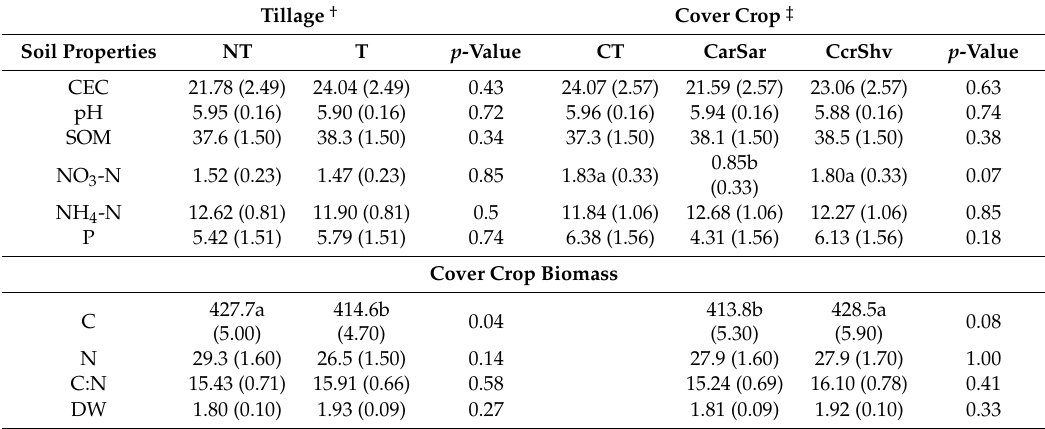
Table 1. Treatment mean values and standard errors of the mean (in parentheses) of soil properties and cover crop biomass variables, which were measured after five years of tillage and cover crop rotation treatments. The soil properties included the cation exchange capacity (CEC, cmol kg − 1 ), soil pH (pH), and the levels of soil organic matter content (SOM, g kg − 1 ), nitrate (NO 3 -N, mg kg − 1